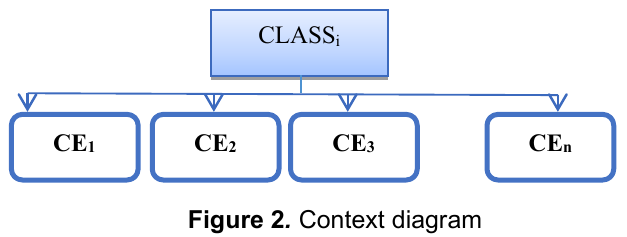
Figure 2 . Context diagram